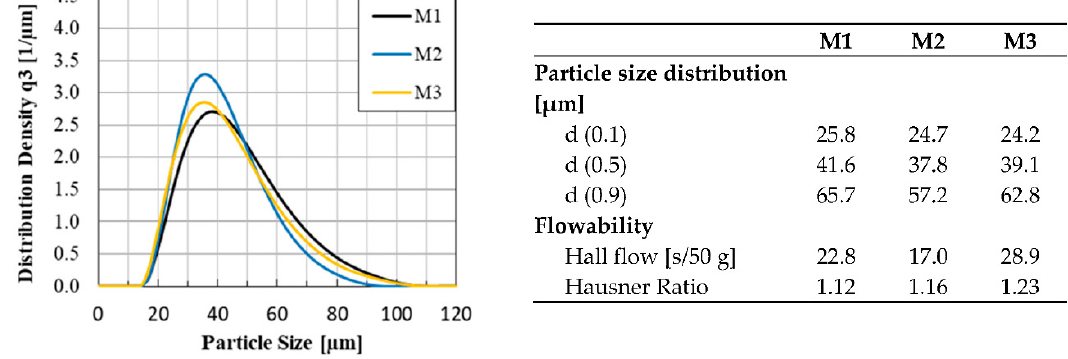
Figure 3. Powder blends characteristics of M1 (black), M2 (blue) and M3 (yellow) ( left : diagram, right : numbers).